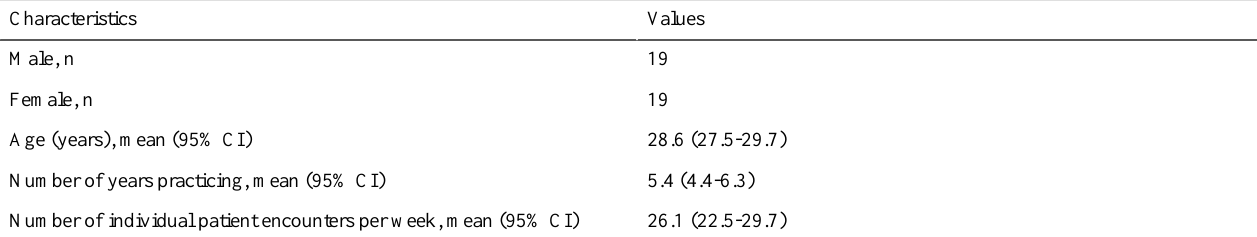
Table 1. Characteristics of participants.